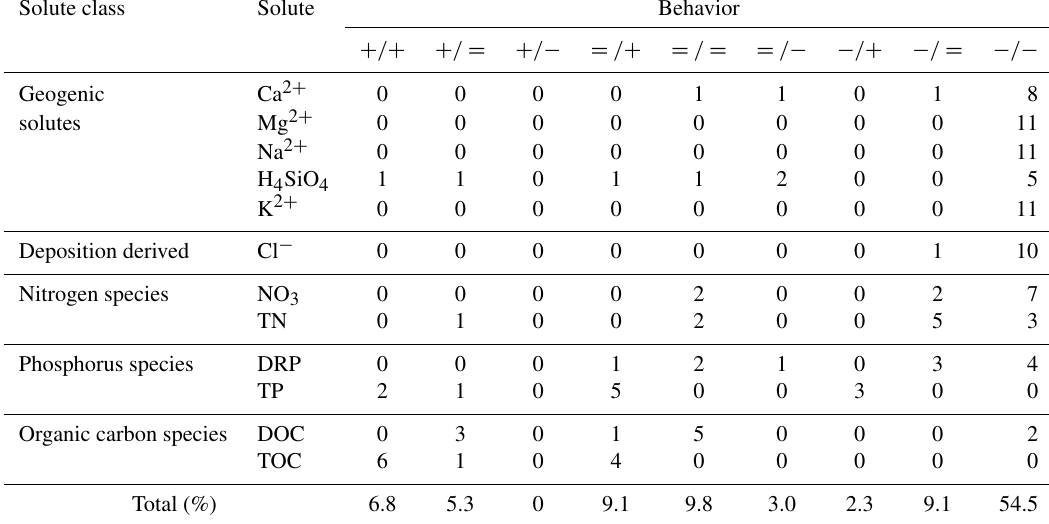
Table 2. Results of the C – Q relations analysis. The symbols “ + ”, “ − ”, and “ = ” refer to the possible behavior combinations described in Fig. 7, while the numbers indicate how many catchments exhibit a specific behavior for each solute. The solutes are classified as reported in the first